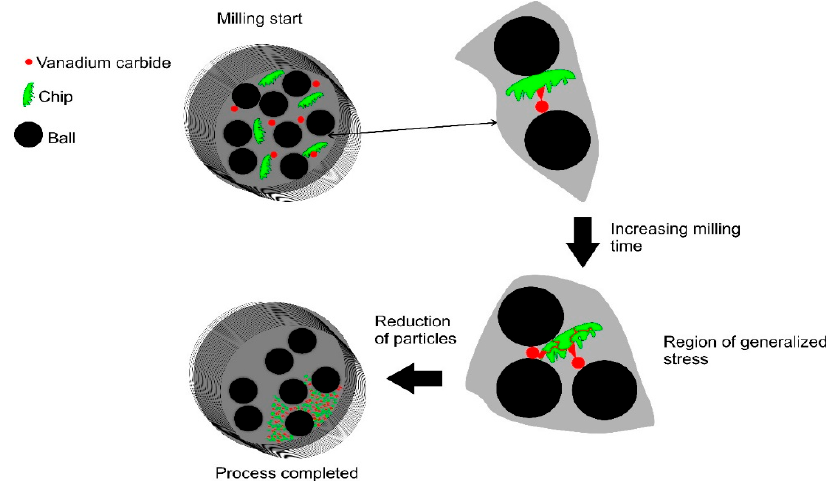
Figure 9. Mechanism of milling with addition carbide of the stainless steel duplex chips.